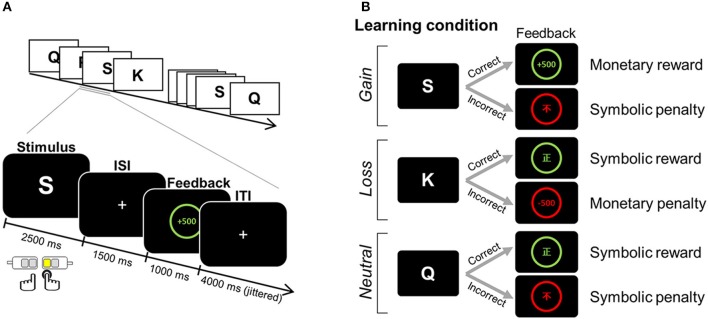
Example of an experimental task. (A) Paradigm of the feedback learning task. One English letter was presented as a learning stimulus for which a response was selected from one of four alternatives. Based on the feedback that followed, the association between a given learning stimulus and a target response was to be learned in a trial-and-error fashion. (B) The positive and negative feedbacks for correct and incorrect choices differed, depending on three learning conditions assigned to the association: monetary reward and symbolic penalty for the gain condition; symbolic reward and monetary penalty for the loss condition; and symbolic reward and symbolic penalty for the neutral condition. ISI, inter-stimulus interval; ITI, inter-trial interval. Adapted from Kim et al. (1).